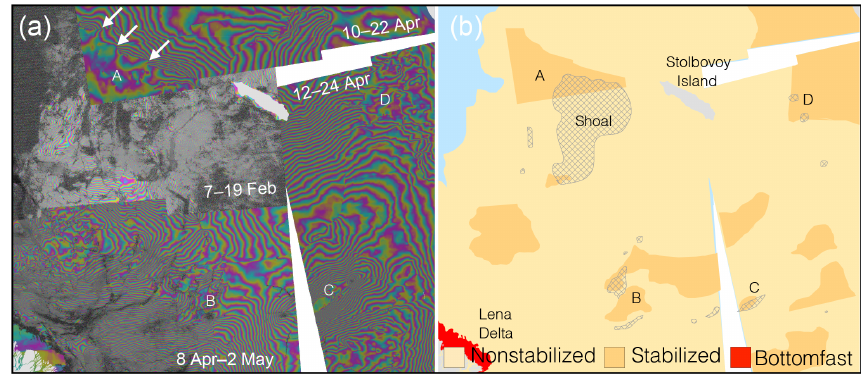
Figure 13. (a) Sentinel-1 interferograms over Laptev Sea near Stolbovoy Island between February and May 2017. (b) Outlined nonstabilized (light orange) and stabilized (dark orange) ice. Shallow areas ( < 10m; Jakobsson et al., 2012) are marked with gray cross hatching. Stabilized ice that is likely supported by grounding near shallow features are marked A–D and further discussed in the text. Land is masked out in light